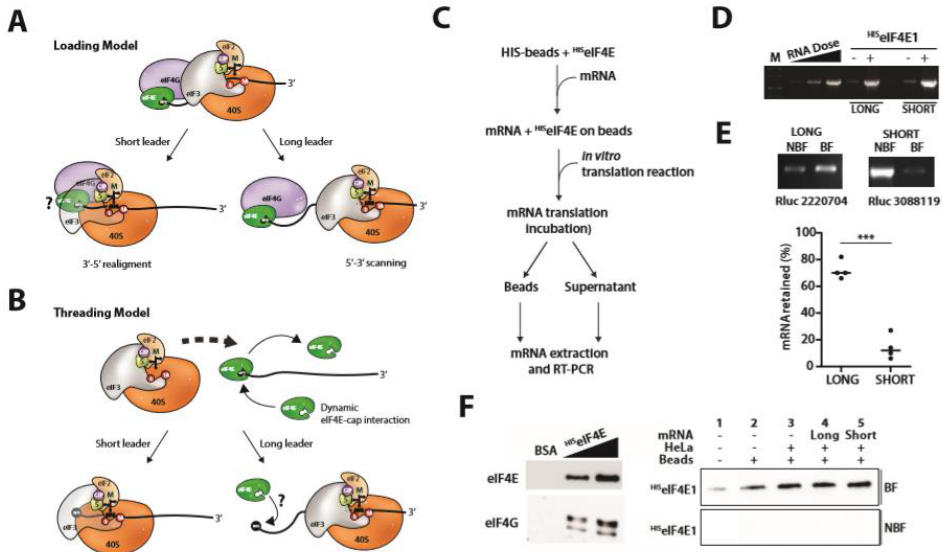
Figure 2. Translation from short and long TLs immobilized on a solid phase matrix via His eIF4E: fate of the transcript. Schematic representations of 43S recruitment via the loading ( A ) and threading ( B ) models on long versus short 5 ′ TLs. The different initiation factors are all indicated. The fate of eIF4E during both processes is indicated. Loading onto a 5 ′ TL long does not necessarily oblige eIF4E release since no realignment post-recruitment is required, however, this is unclear with a 5 ′ TL short (indicated as an ?). In the threading model the cap enters the 43S ribosome via the A site and this presumably requires, due to steric constraints, eIF4E release as the transcript enters the RNA channel on the surface of the ribosome. This would occur independent of TL length. ( C ) Schematic representation of the experimental protocol. HIS-Dynabeads carrying bacterially expressed HIS eIF4E were used to immobilise in vitro generated capped mRNAs carrying either a short (8 nt) or a long Kozak TL fused to an RLuc reporter gene. As a control, beads were incubated with the same amount of BSA. These were then incubated in a cell extract for 10 min. Bead/binding fraction (BF) and supernatant/non-binding fractions (NBF) were separated and the RNA extracted (an aliquot of the supernatant was retained to measure RLuc reporter activity). Transcript levels in both fractions was measured by RT-PCR. ( D ) Agarose gel analysis of the RT-PCR amplicon. Transcripts carrying either a capped long or short 5 ′ TL were incubated with HIS-Dynabeads carrying (+) or not carrying (-) HIS eIF4E. Bound RNAs were recovered and analyzed by RT-PCR. M indicates size markers. An RNA dose is included (1 ng, 10 ng and 50 ng of an RLuc transcript) to show that the signals are in the linear range. ( E ) A representative RT-PCR analysis of the NBF and BF fractions after incubation in